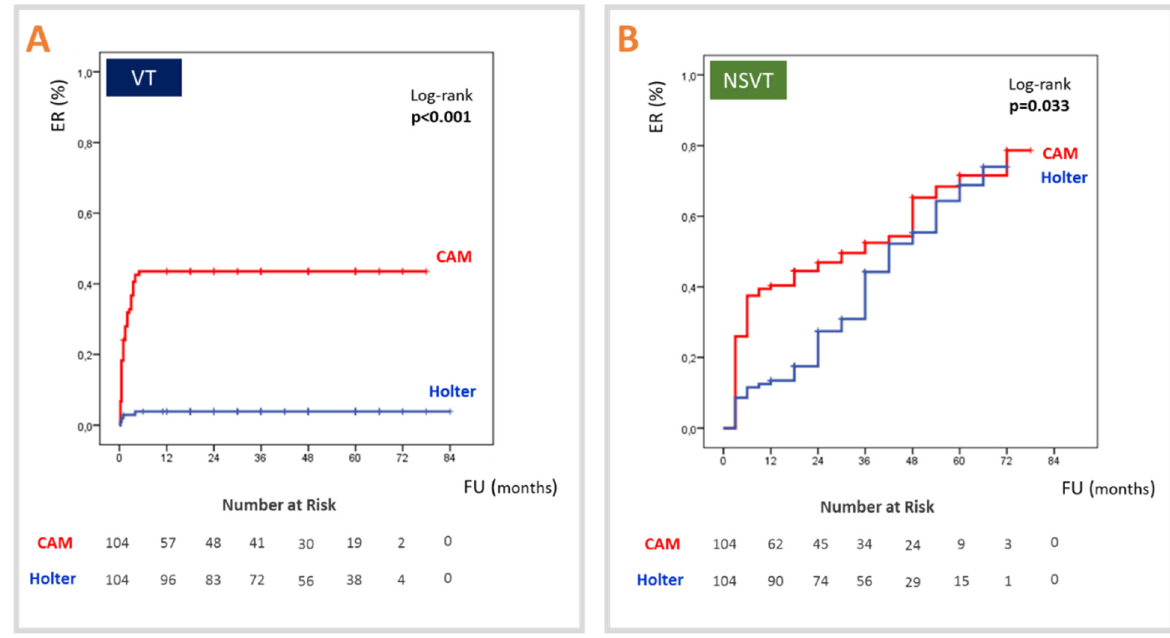
Figure 2. Detection of ventricular arrhythmias by CAM vs. sequential 24 h Holter ECGs. Kaplan–Meier curves are shown for the endpoint of VT (panel A ) and NSVT (panel B ). CAM = continuous arrhythmia monitoring (red); ER = event rate; FU = follow up; Holter = 24 h Holter ECG (blue); NSVT = nonsustained ventricular tachycardia; VT = ventricular tachycar- dia.